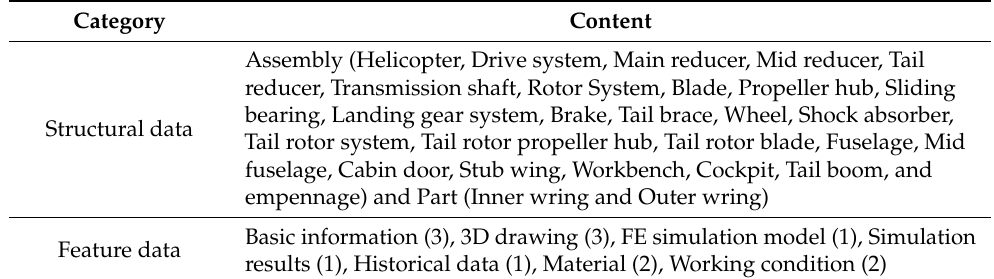
Table 3. Checked modeling objects of the digital twin model in this case. Category Content Assembly (Helicopter, Drive system, Main reducer, Mid reducer, Tail reducer, Transmission shaft, Rotor System, Blade, Propeller hub, Sliding bearing, Landing gear system, Brake, Tail brace, Wheel, Shock absorber, Structural data Tail rotor system, Tail rotor propeller hub, Tail rotor blade, Fuselage, Mid fuselage, Cabin door, Stub wing, Workbench, Cockpit, Tail boom, and empennage) and Part (Inner wring and Outer